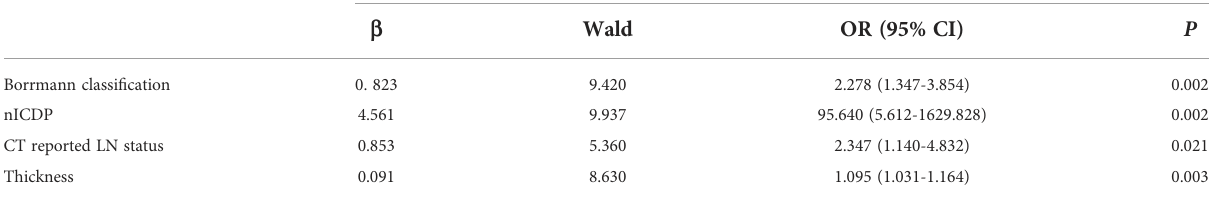
TABLE 4 Risk Factors for lymphovascular invasion in gastric